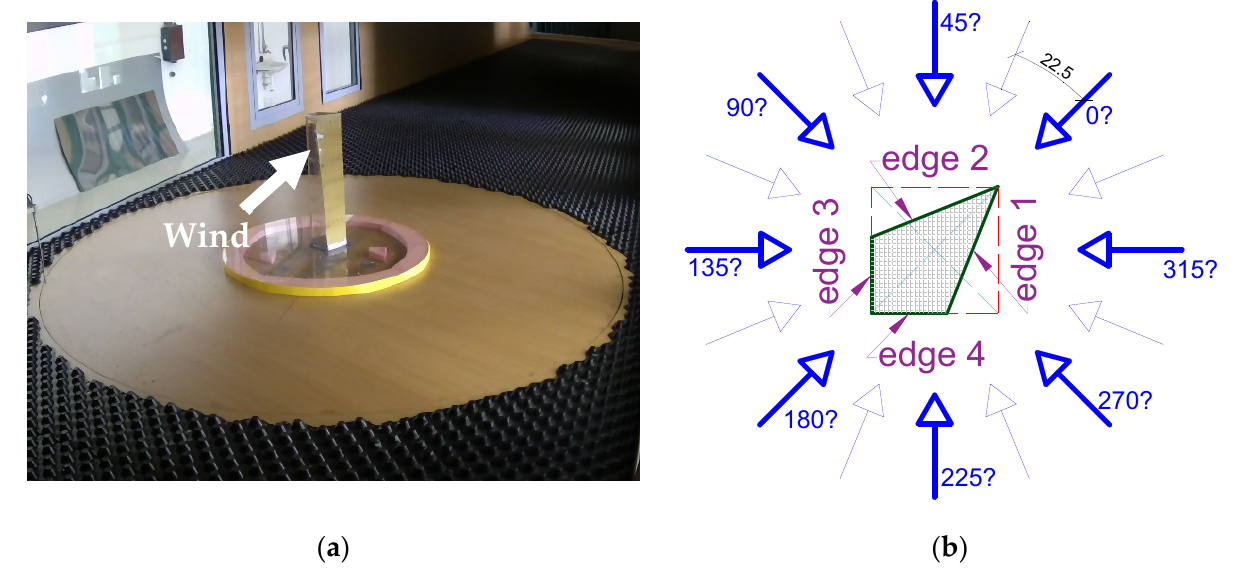
Figure 6. ( a ) Stand-alone atypical structure in a wind tunnel (wind direction 225°); ( b ) all considered wind directions.